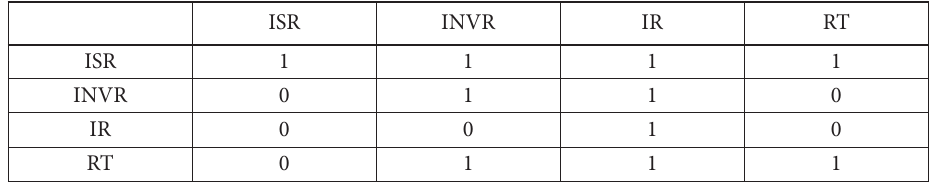
Table 3. A matrix